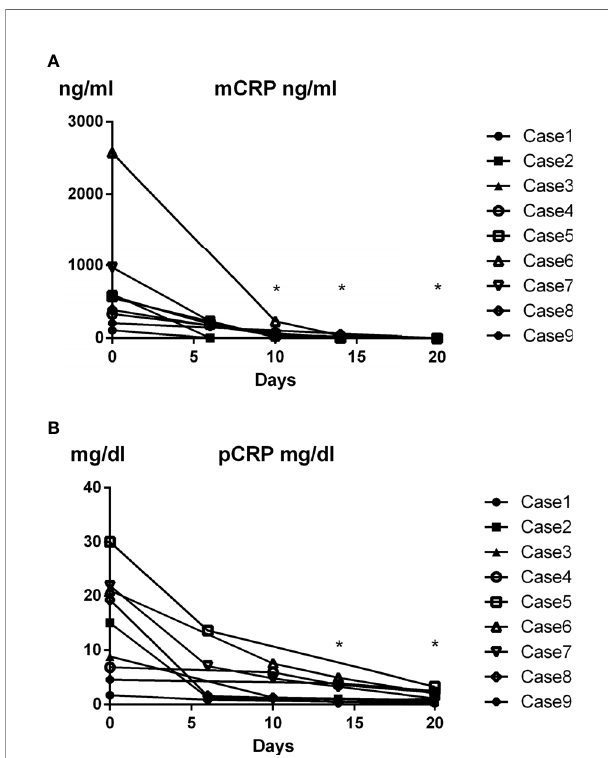
FIGURE 4 | Time course of changes in plasma mCRP level in AOSD patients. Dynamic changes in plasma mCRP concentration in AOSD patients after immunosuppressive therapy were evaluated (n = 9) at the indicated time points. Plasma mCRP levels decreased more rapidly than pCRP levels following immunosuppressive therapy. Statistical analysis was performed using a Wilcoxon signed-rank test. * P < 0.05. mCRP concentration on day 0 and indicated days were